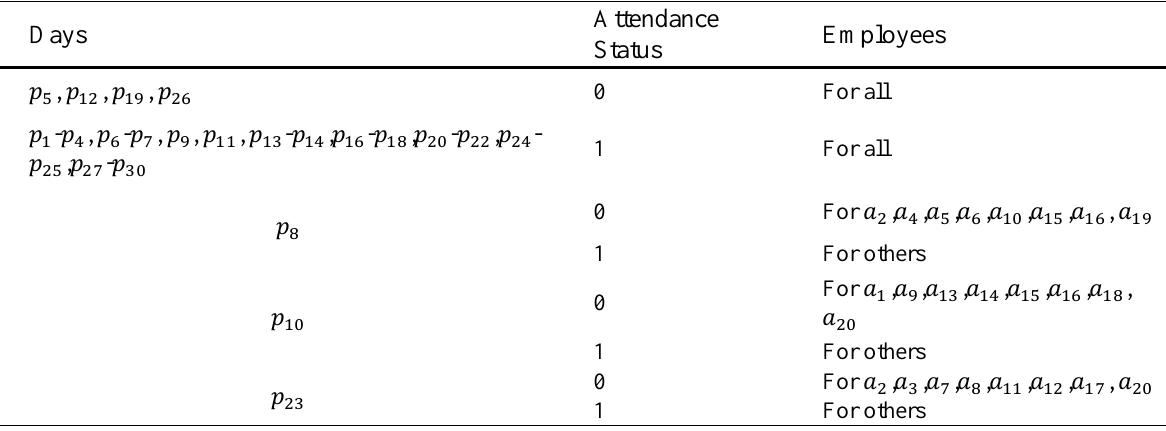
Table 1. Optimum mode of attendance or absence of staff during the months of the month.